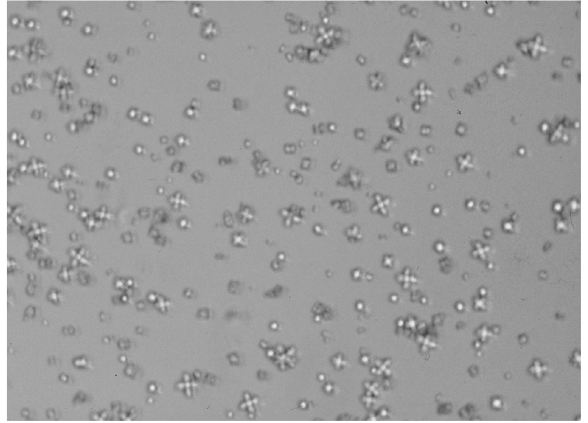
Figure 2 – Same morphology as figure 1 but crystals increased in number, as SS increased.